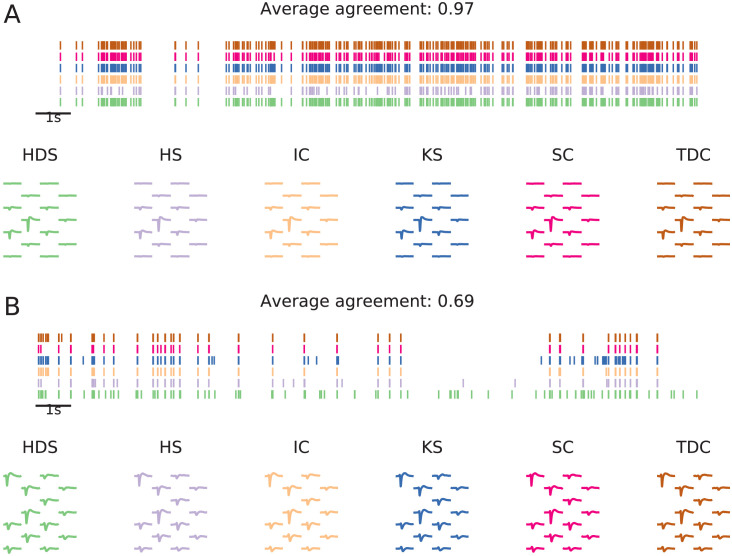
Examples of matched units in a Neuropixels recording.The illustration shows units from six spike sorters that were matched by spike train comparison. Panel (A) shows a unit with high agreement score (0.97), and panel (B) a lower agreement score (0.69). In both panels, the top plot shows the spike trains (the first 20 s of the recording) found by each sorter, and below unit templates (estimated from waveforms of 100 spikes randomly sampled from each unit) are shown.